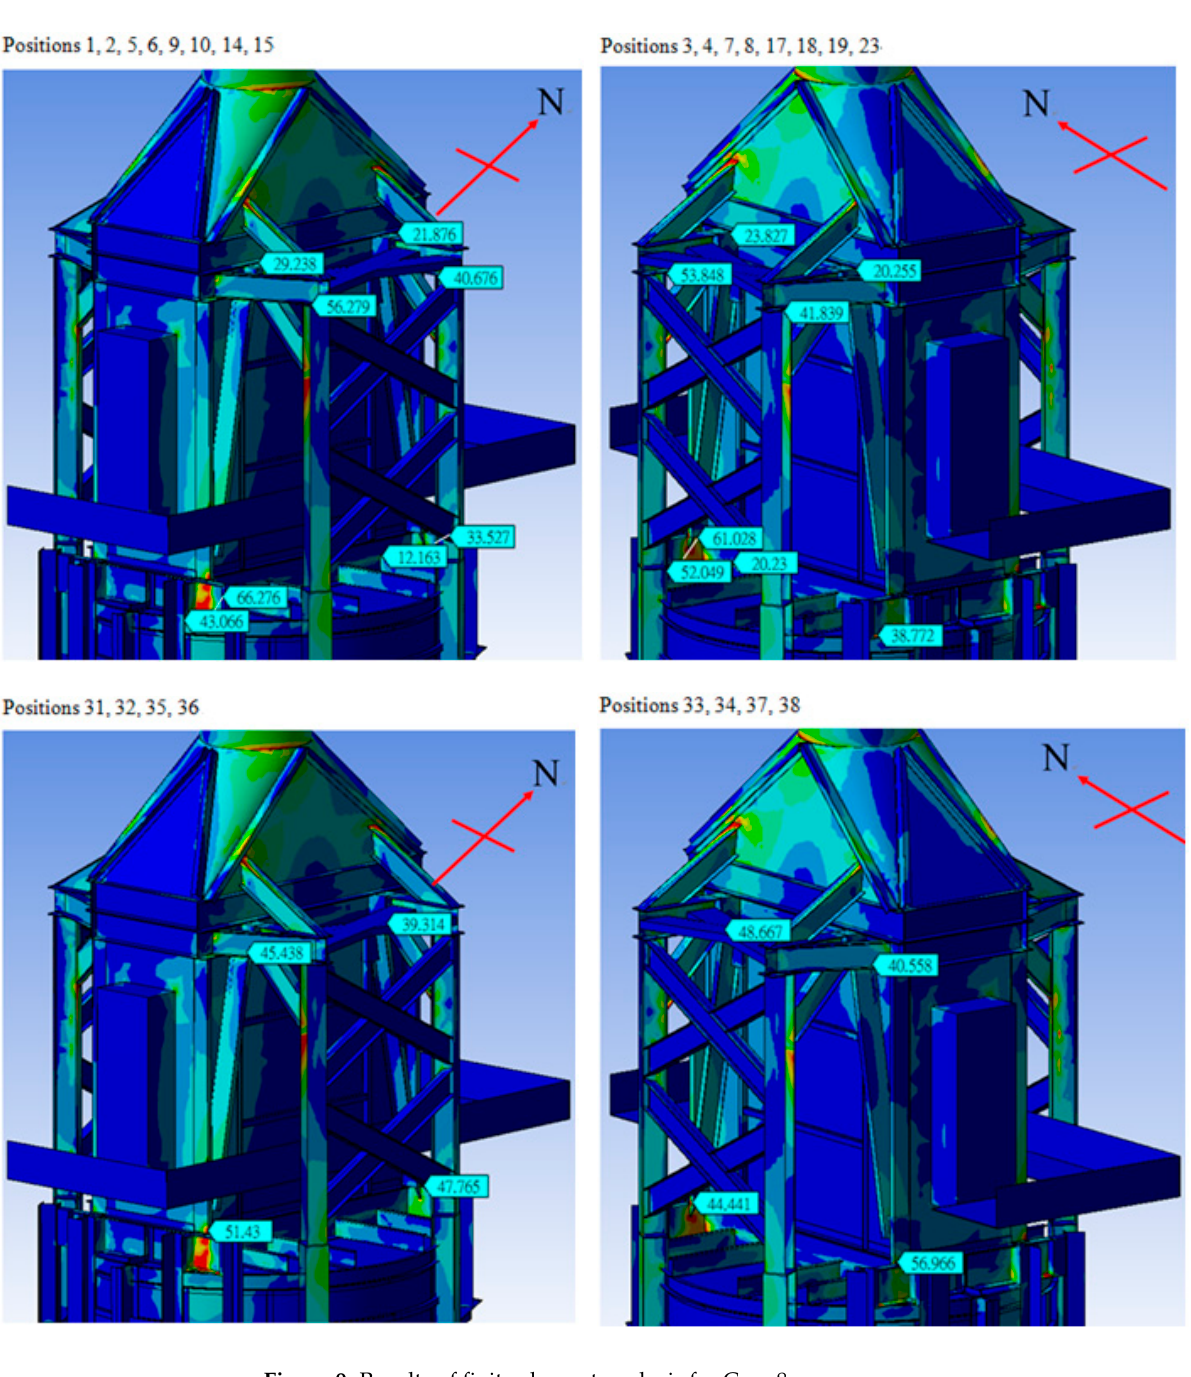
Figure 9. Results of finite element analysis for Case 8.